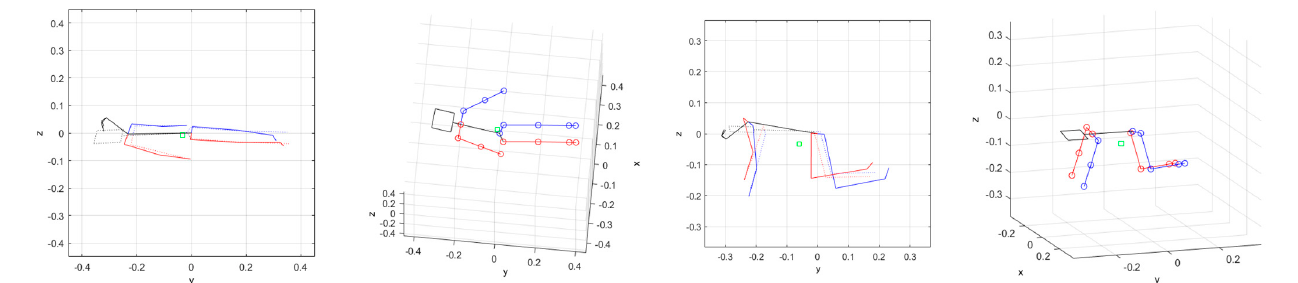
Figure 13. Two-dimensional poses and the corresponding 3D poses reconstructed by the proposed approach viewed from various angles (red line: right parts, blue line: left parts).